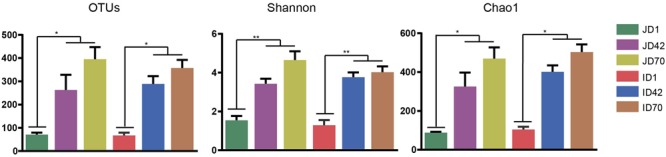
Diversity and richness indices in the jejunum and ileum of neonatal sika deer at days 1, 42, and 70. ∗p < 0.05, ∗∗p < 0.01. JD, jejunum day; ID, ileum day.